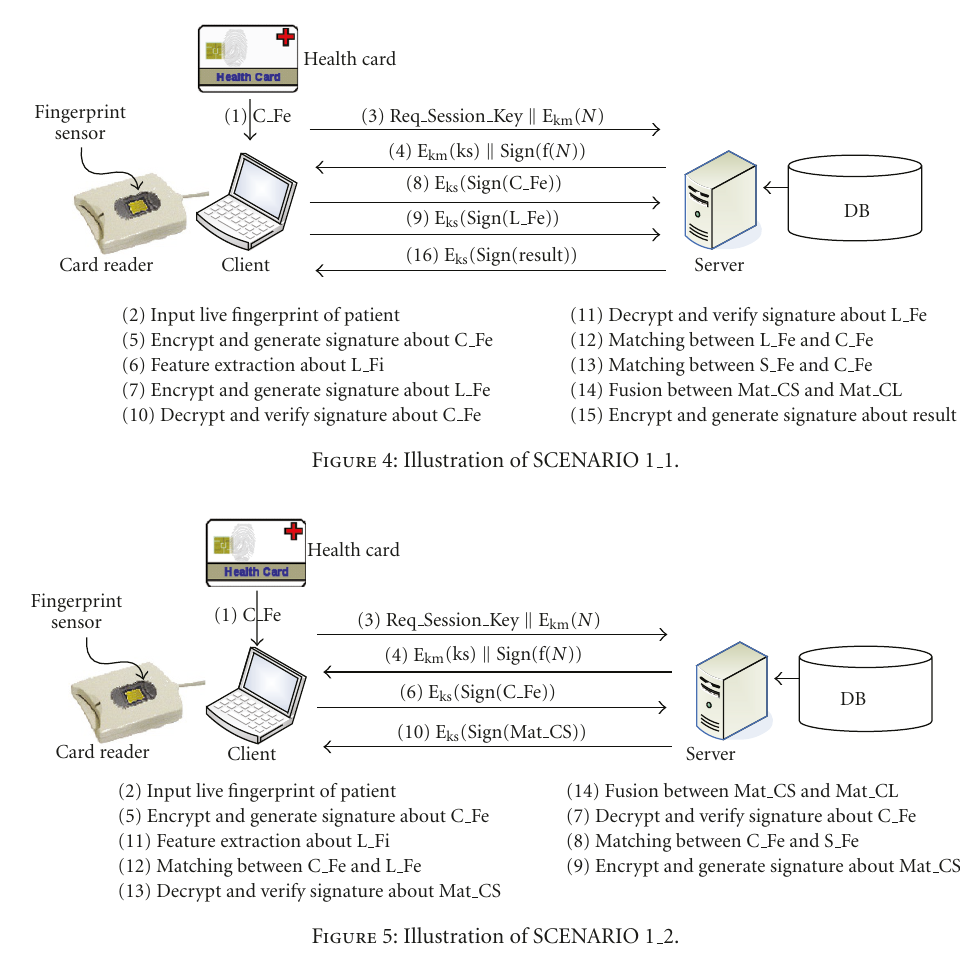
Figure 5: Illustration of SCENARIO 1 2.